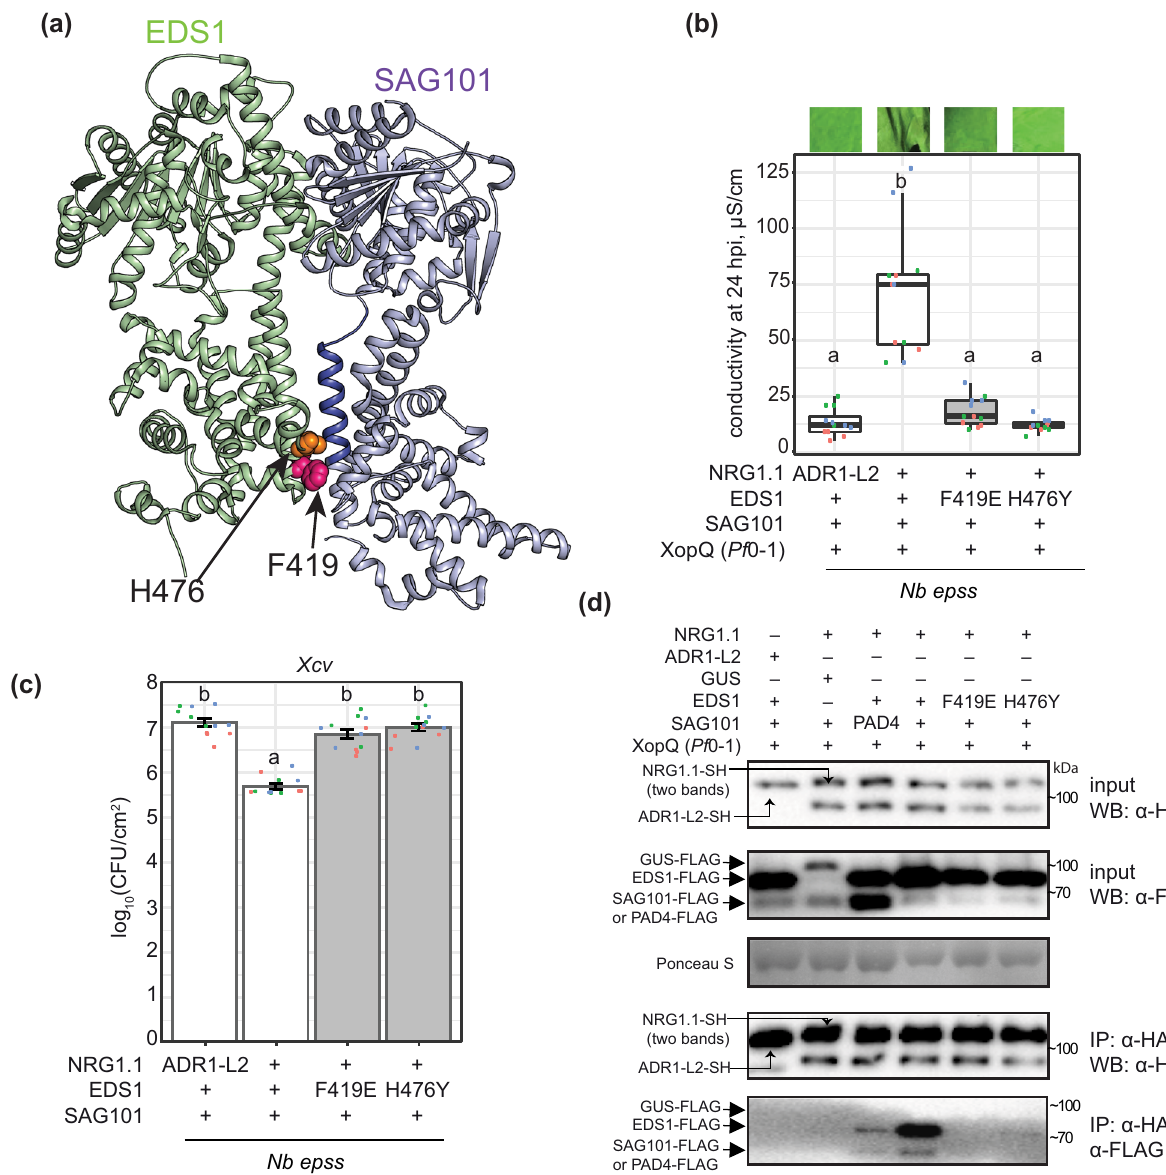
Fig. 5 Effector-dependent NRG1 – EDS1 – SAG101 association requires a functional EDS1 EP domain. a The Arabidopsis EDS1 (green) — SAG101 (purple) heterodimer crystal structure (PDB: 4NFU) with highlighted EP domain cavity essential for TNL-triggered cell death. An α -helix of the SAG101 EP domain (blue) and residues F419 (magenta) and H476 (orange) in EDS1 EP domain are shown as ribbon and spheres, respectively. b , c